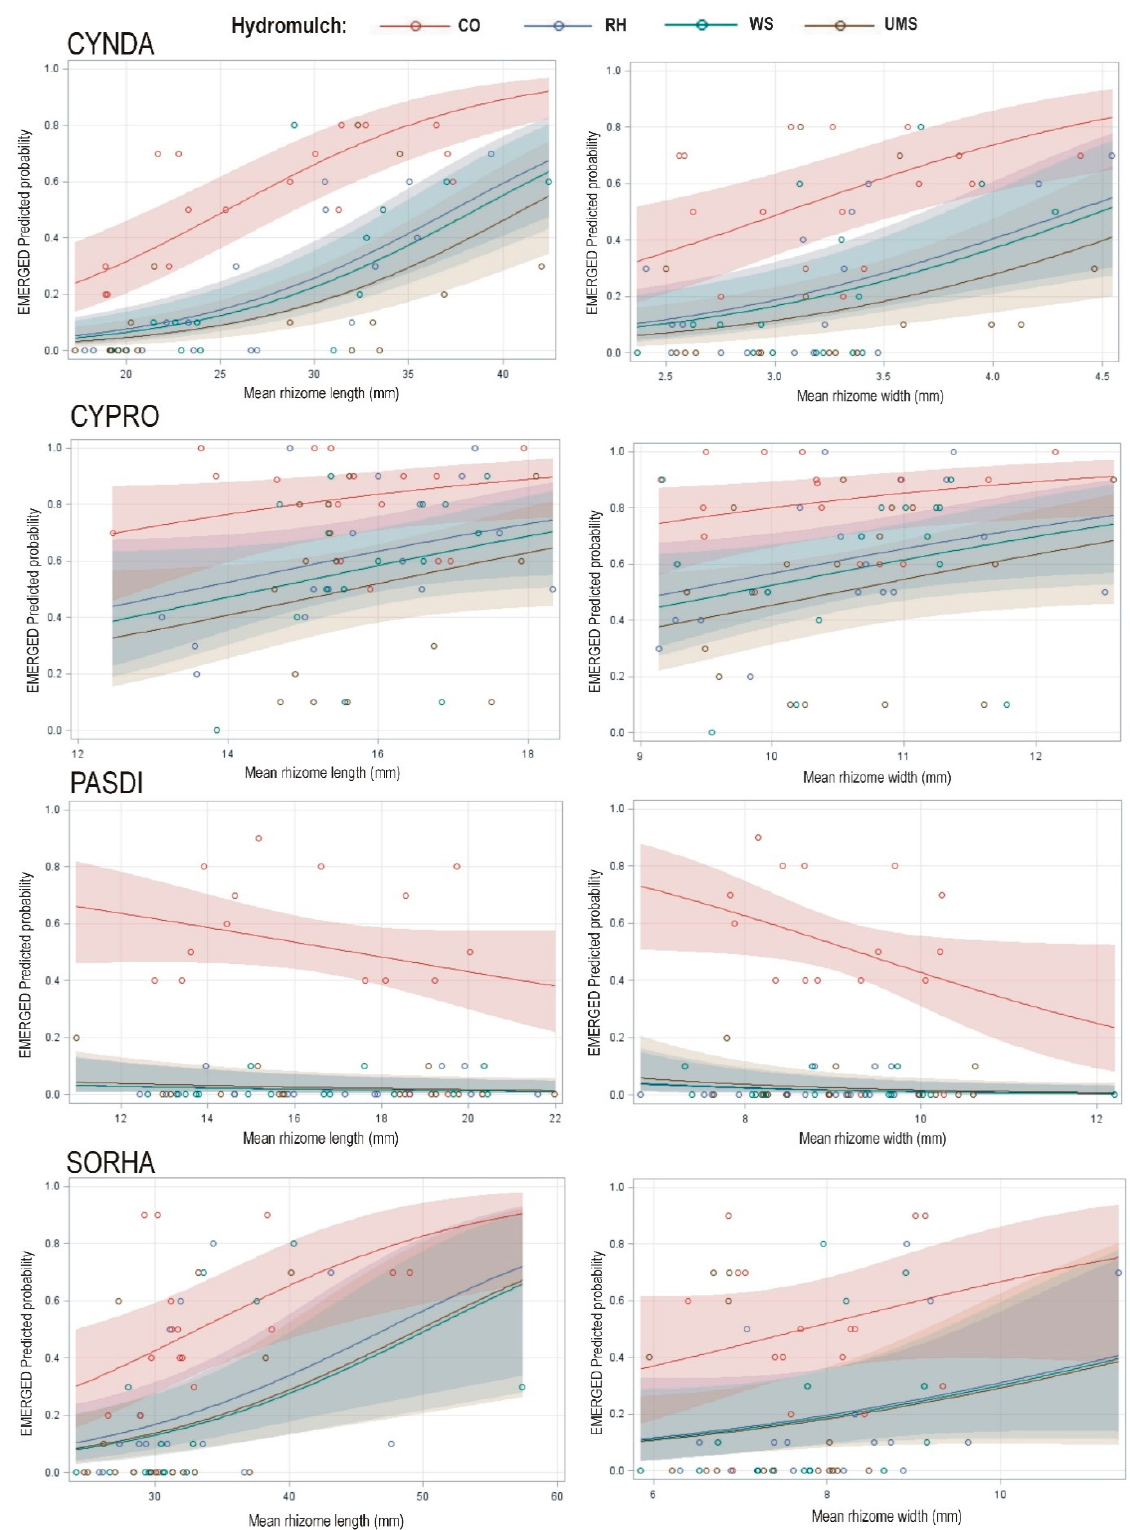
Figure 2. Variation in the predicted probability of the proportion of rhizomes that produced emerged shoots (EMERGED) in each type of hydromulch as a function of mean rhizome length ( left ) or mean rhizome width ( right ), species by species. Observed values ( ∘ ) and fitted logit functions (lines) with 95% confidence limits from the parameters estimated in the generalized linear model are represented. CYNDA: Cynodon dactylon , CYPRO: Cyperus rotundus , PASDI: Paspalum dilatatum , SORHA: Sorghum halepense . CO: non-mulched control, RH: rice husk, UMS: used mushroom substrate, WS: wheat